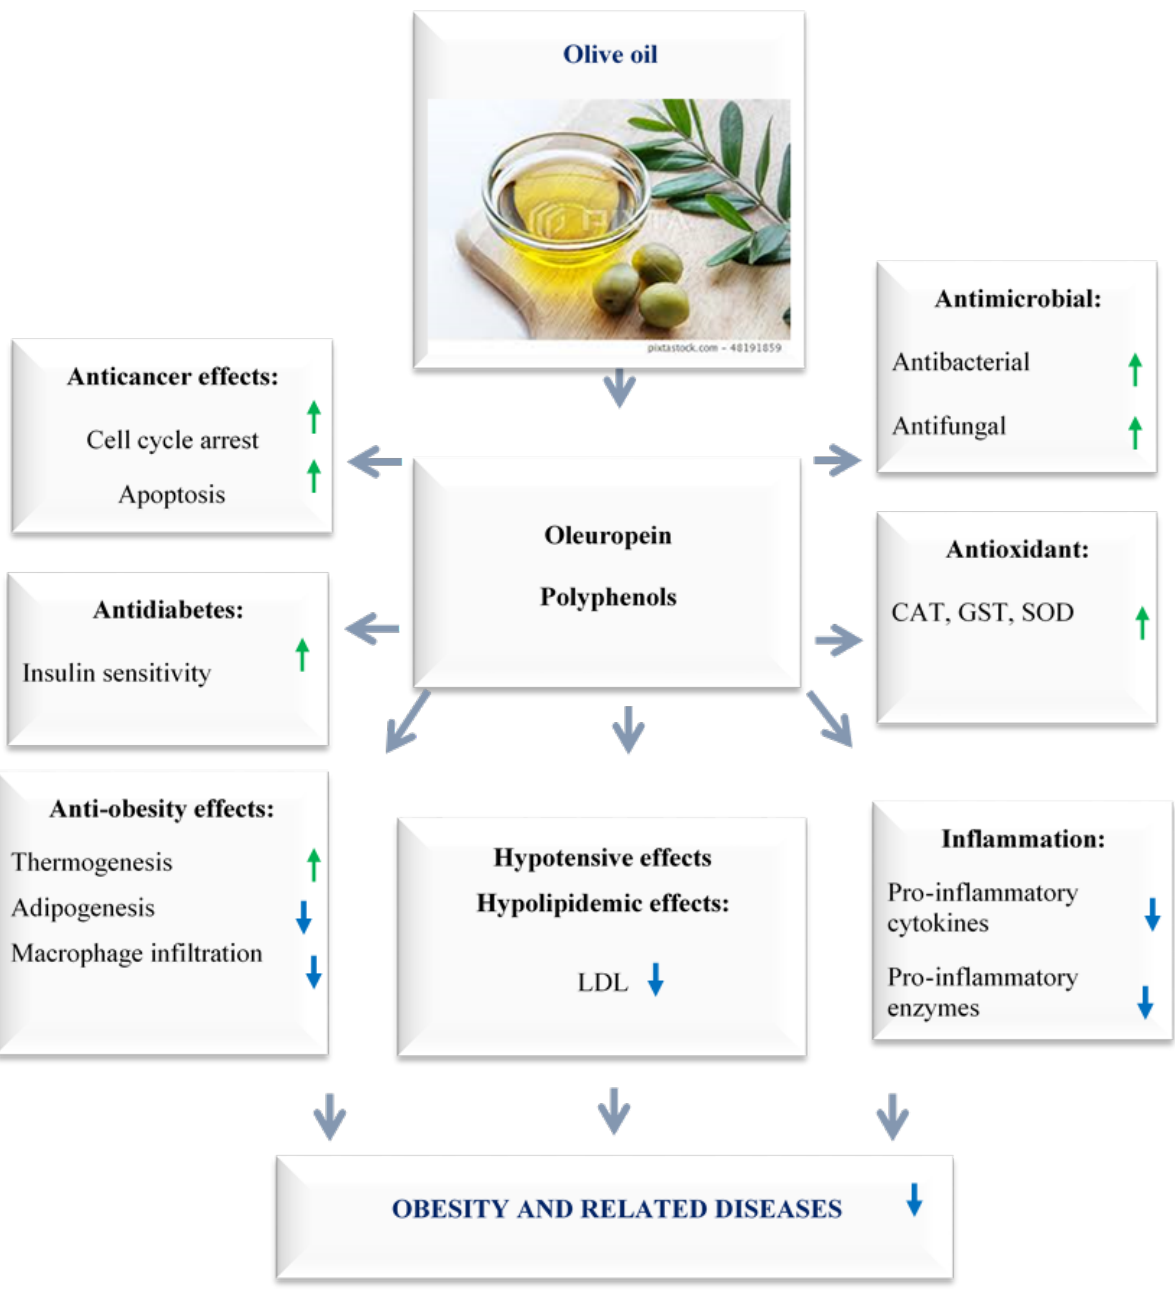
Figure 6. Management of obesity-related diseases by olive oil and its derived active compounds. SOD: superoxide dismutase, CAT: catalase, GST: glutathione